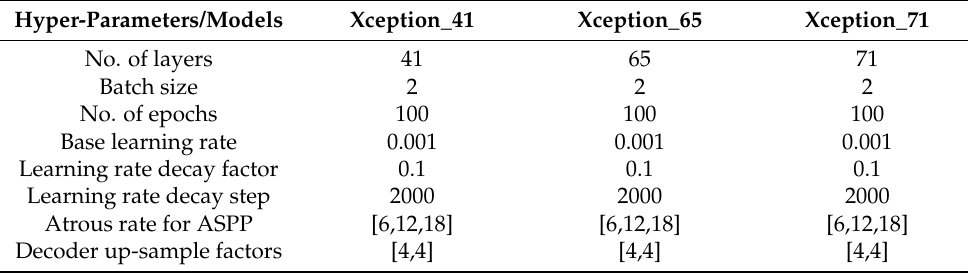
Table 4. The hyper-parameter settings for training and